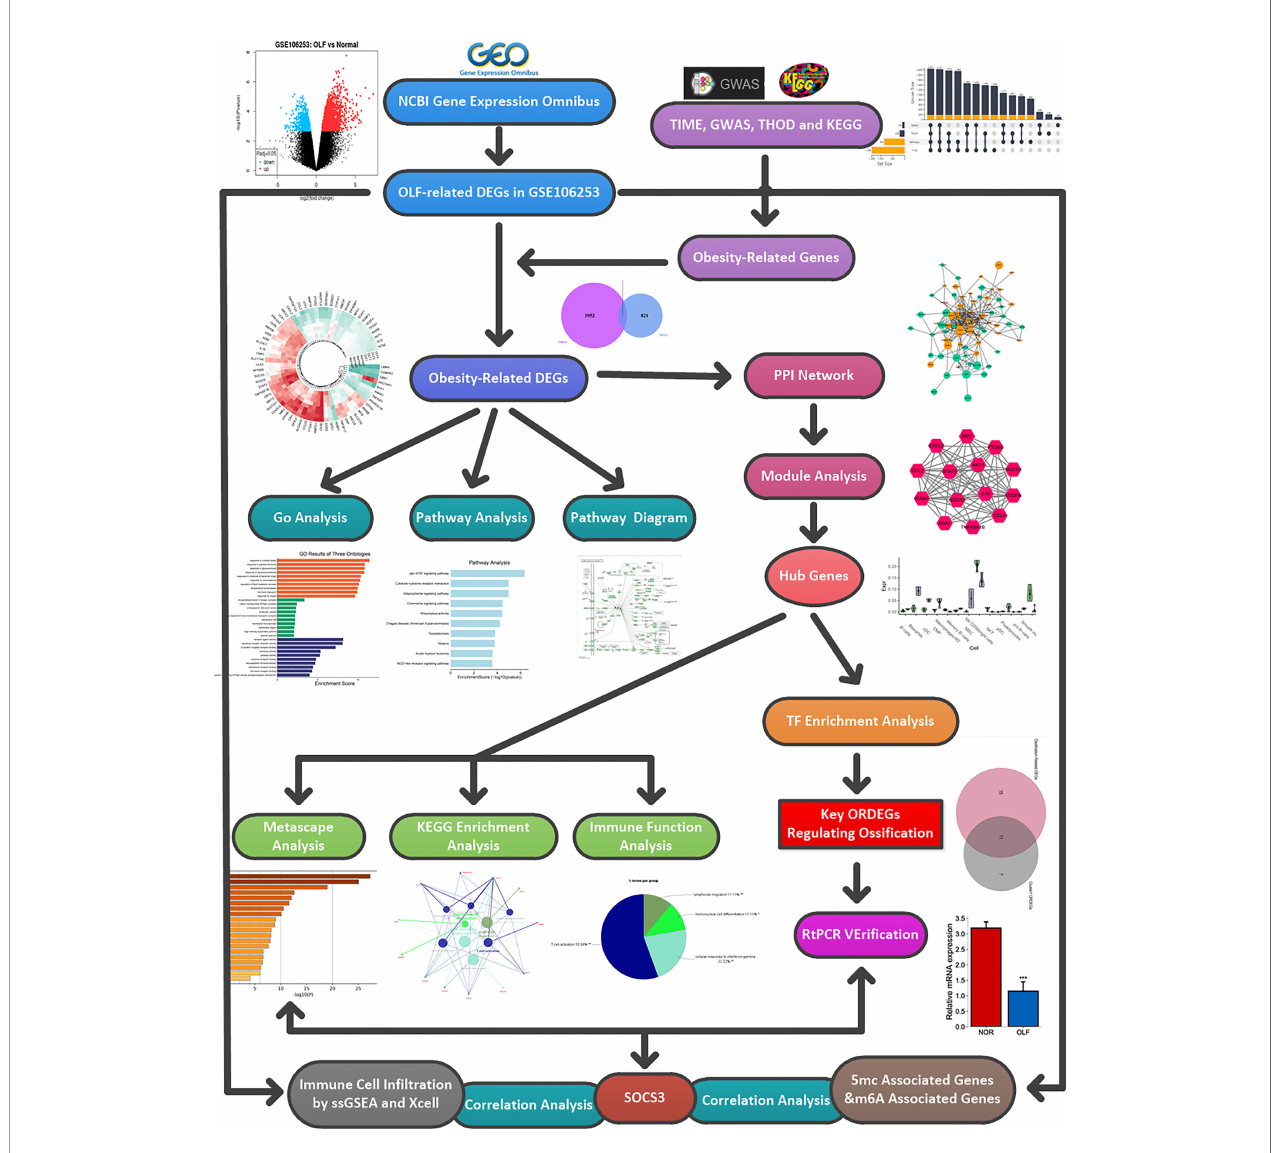
FIGURE 1 | Flow chart of the whole analysis